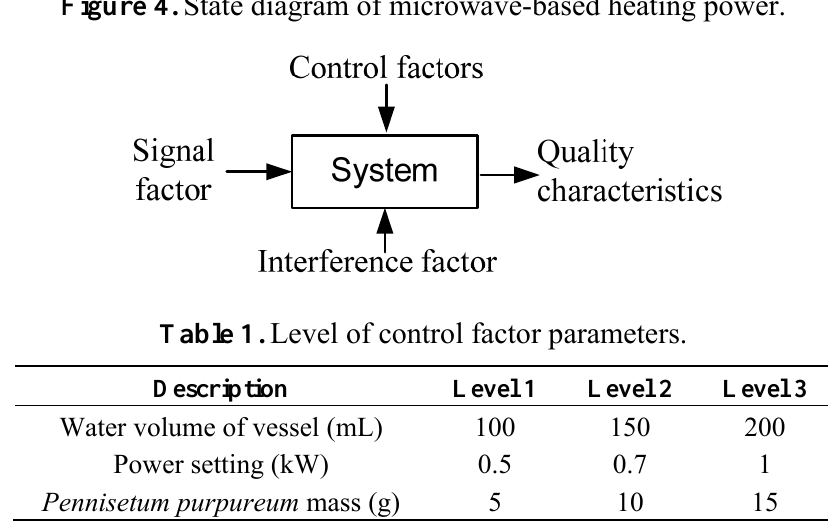
Figure 4. State diagram of microwave-based heating power.